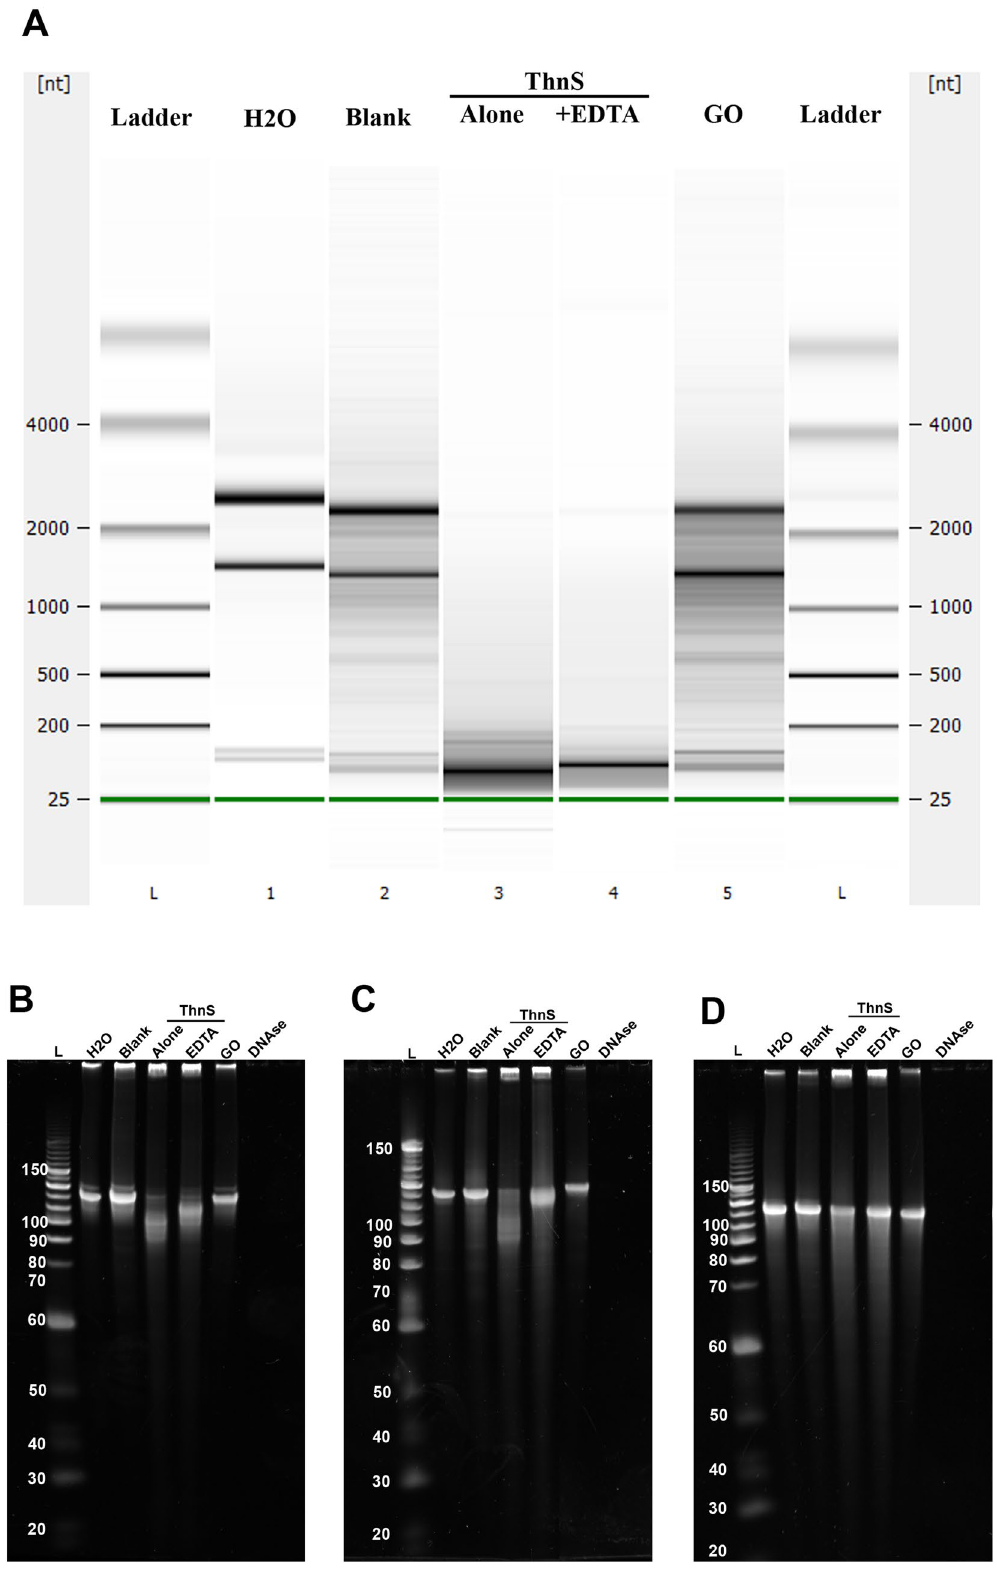
Figure 5. Nuclease and ribonuclease activities of the purified ThnS enzyme. ( A ) Degradation of bacterial total RNAs by the ThnS enzyme in the presence and absence of metallo-β-lactamase inhibitor (EDTA). GO (Glycine Oxidase) is used here as negative control enzyme; ( B ) Nuclease activity of ThnS on dsDNA; ( C ) Nuclease activity of ThnS on forward ssDNA ; ( D ) Nuclease activity of ThnS on reverse ssDNA. The ThnS activity was tested in the presence and absence of a metallo-β- lactamase inhibitor (EDTA). Glycine Oxidase (GO) and DNAse enzymes were used here as negative and positive controls, respectively. “Blank” refers to the empty vector eluted under the same conditions as that of the expressed ThnS